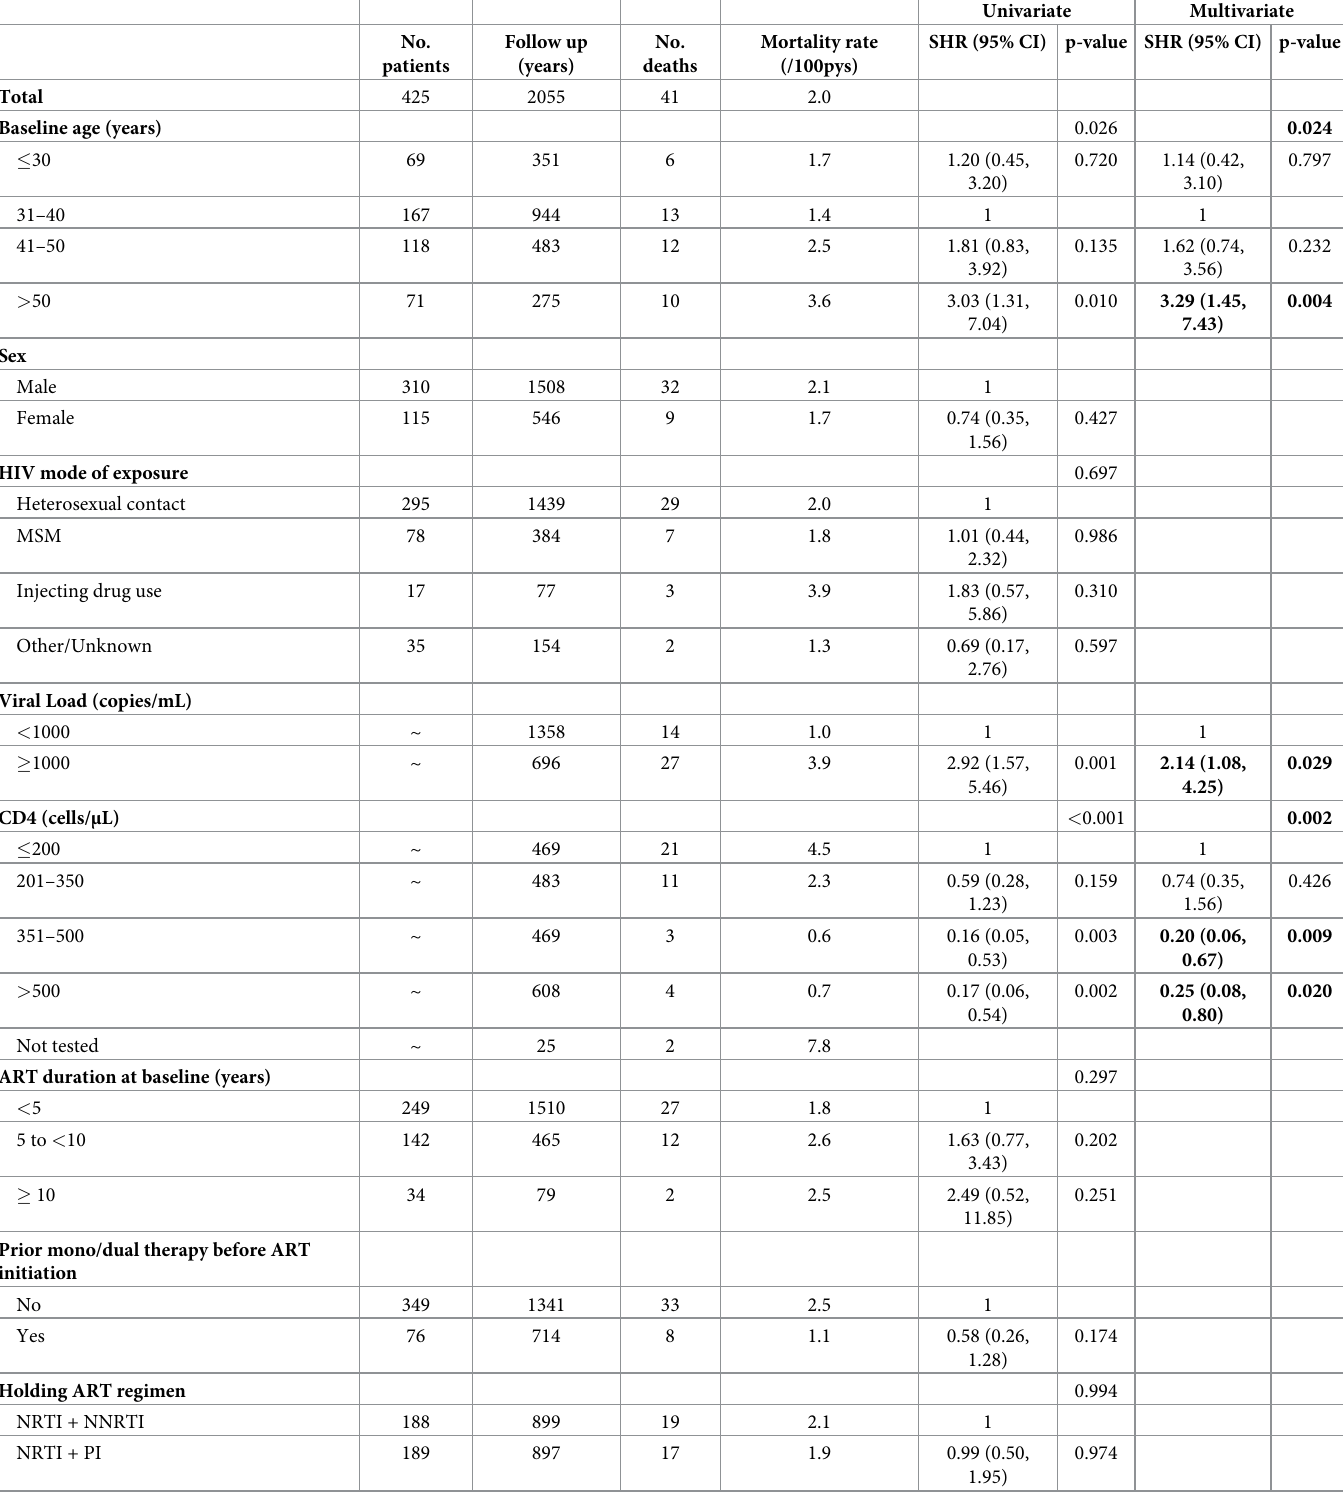
Table 3. Factors associated with mortality among patients who were on holding